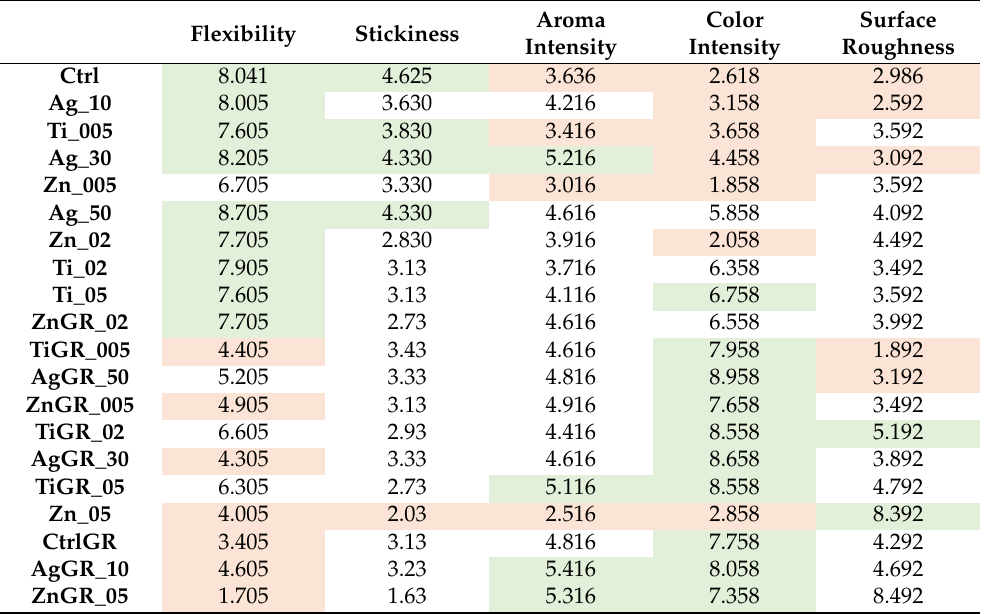
Table 2. Adjusted mean values of evaluation within the quantitative descriptive analysis of edi- ble packaging.